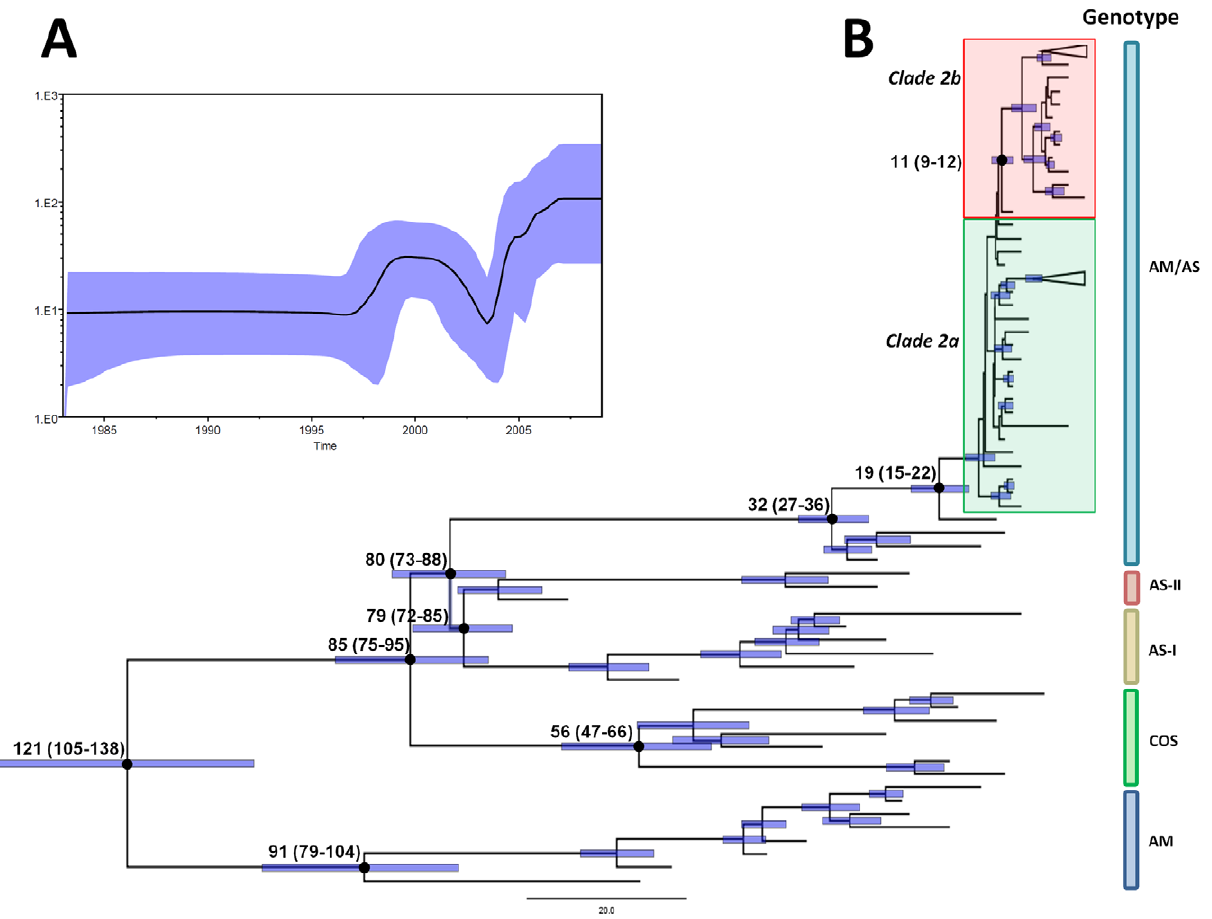
Figure 3. Maximum clade credibility (MCC) tree and Bayesian Skyline plot of the analyzed DENV-2. A) Bayesian coalescent inference of genetic diversity and population dynamics using the Bayesian Skyline plot available in BEAST 1.6.1., for DENV-2 strains of American/Asian genotype in Central America. X axis represents years of study and y axis the relative genetic diversity product of the effective population size. Black line represents the mean estimate and the blue shadow, the 95%HPD. B) Maximum clade credibility tree derived from the Bayesian analysis of the envelope protein of DENV-2 with the best fit model (relaxed lognormal clock), showing the mean time to the most recent common ancestor (TMRCA) in each principal node (mean and 95%HPD). The 95% highest probability density (95%HPD) for each node age, are shown as blue bars. DENV-2 genotypes (Sylvatic, American, Asian I and II, Cosmopolitan and American/Asian) are identified. Clades 2a and 2b are highlighted in a green and red shadow, respectively.